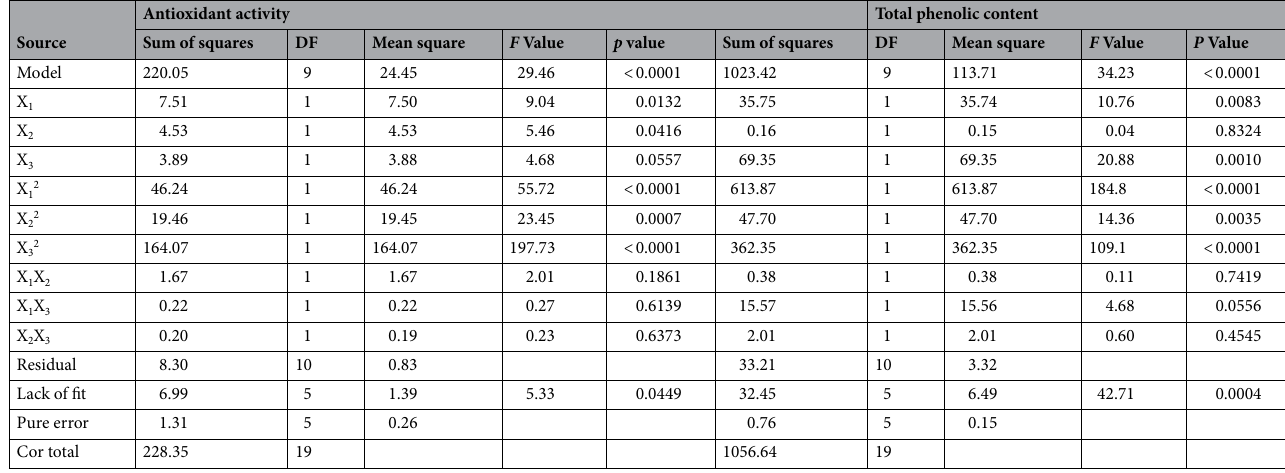
Table 4. Analysis of variance (ANOVA) for response surface quadratic model.